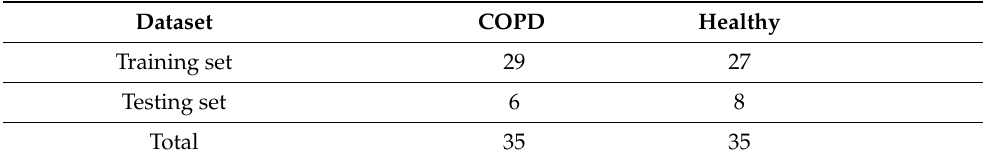
Table 1. Training and testing